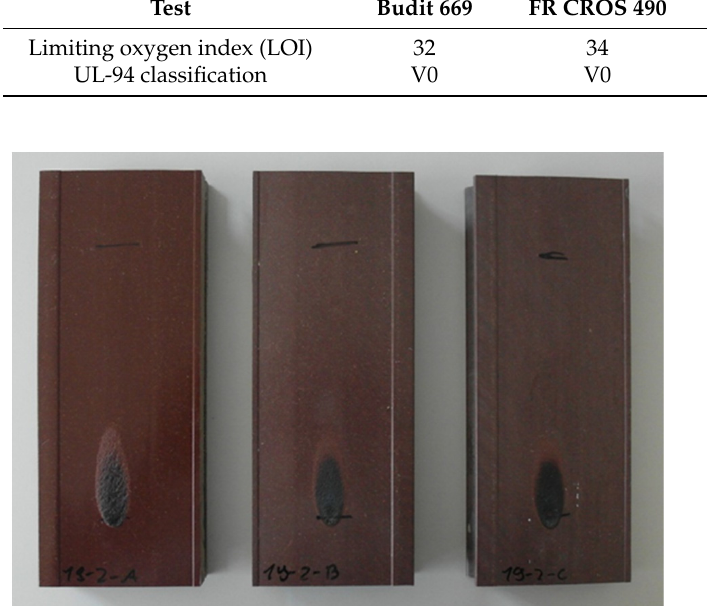
Figure 3. Hollow core profiles after the single flame source test (EN ISO 11925-2). From left to right: reference without FR, profiles with Budit 669, and profiles with FR CROS 490. Horizontal line on profiles indicates 150 mm-mark (vertical flame spread within 60 s after start of the flame treatment shall not be more than 150 mm).